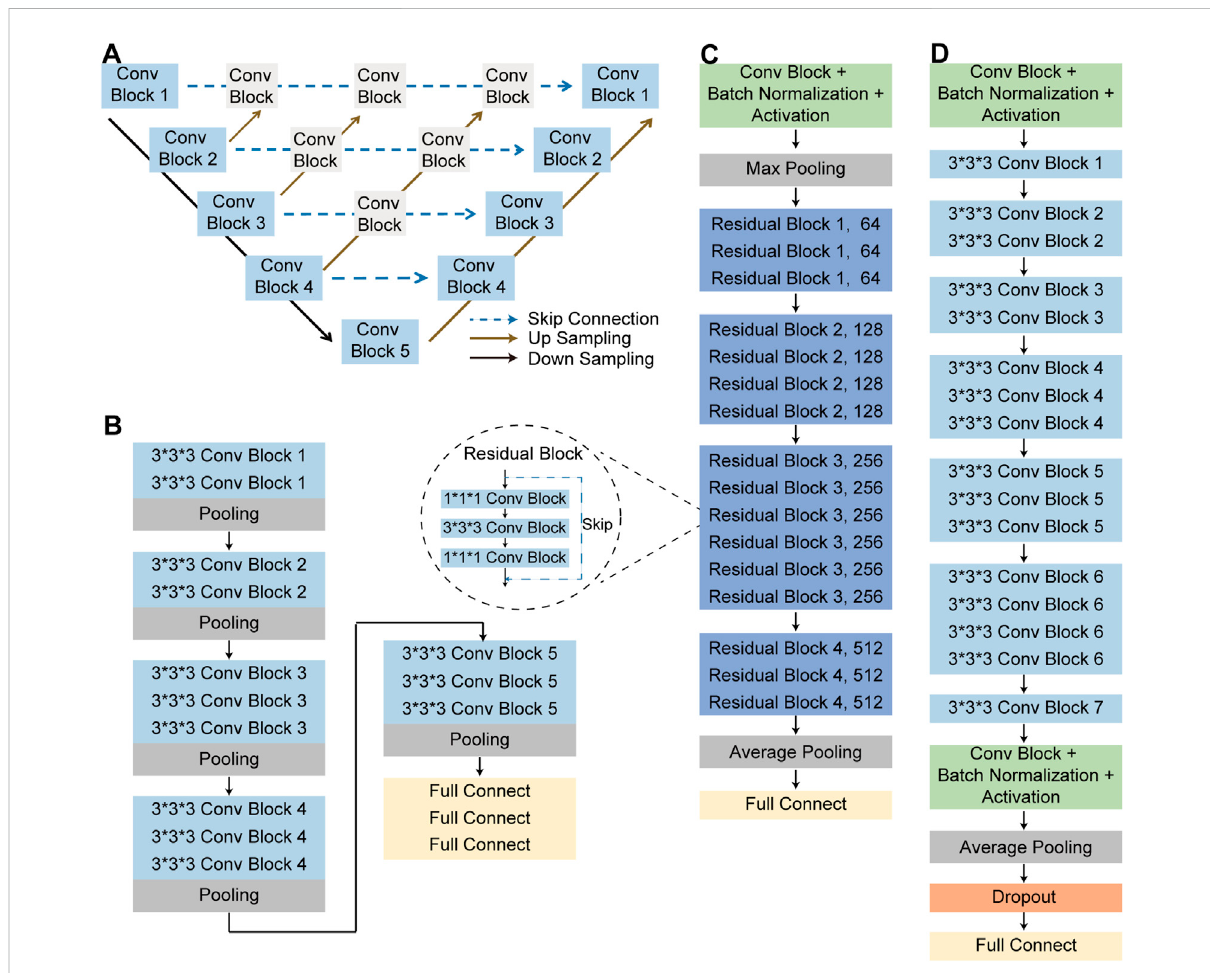
FIGURE 4 The structure of neural networks. (A) Nested UNet network structure. (B) 3D VGG-16 network structure. (C) 3D ResNet-50 network structure. (D) 3D Ef fi cientNet network